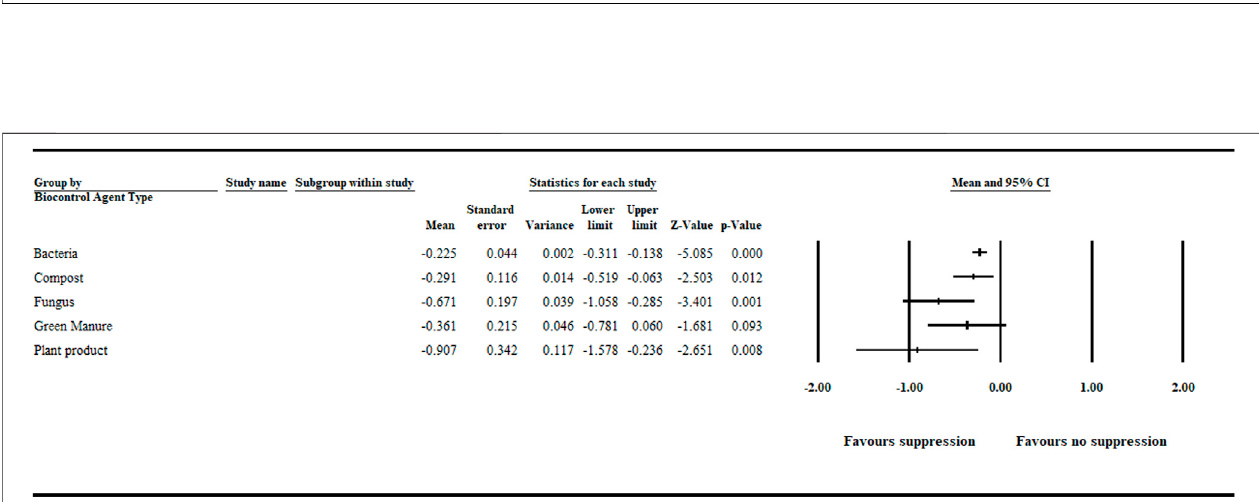
Frontiers in Molecular Biosciences |